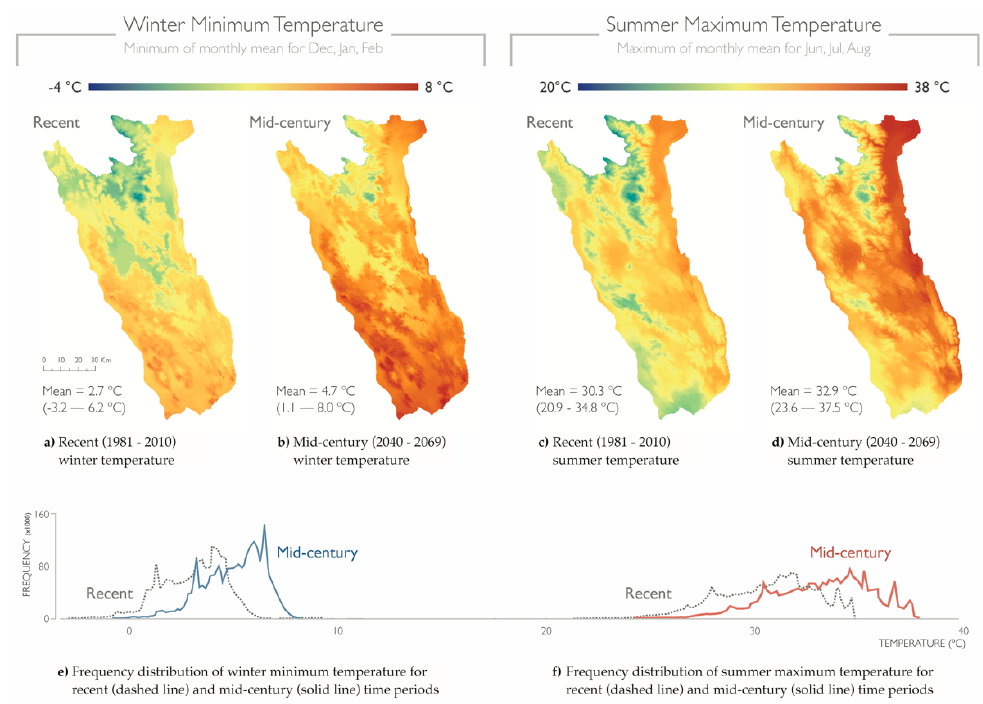
Figure 4. Temperature extremes for summer and winter seasons. Map of the Mayacamas to Berryessa project area overlaid with ( a ) recent (1981–2010) and ( b ) mid-century projections (2040–2069) for mean winter minimum (December, January, and February) temperature, and ( c ) recent and ( d ) mid-century projections for mean summer maximum (June, July, and August) temperature (CNRM-CM5 model, RCP 8.5 emission scenario). Density plots showing the frequency distribution of values for recent (dashed line) and projected mid-century (solid line) for ( e ) mean winter minimum (December, January, and February) and ( f ) mean summer maximum (June, July, and August) temperature. Units are in degrees Celsius (°C).